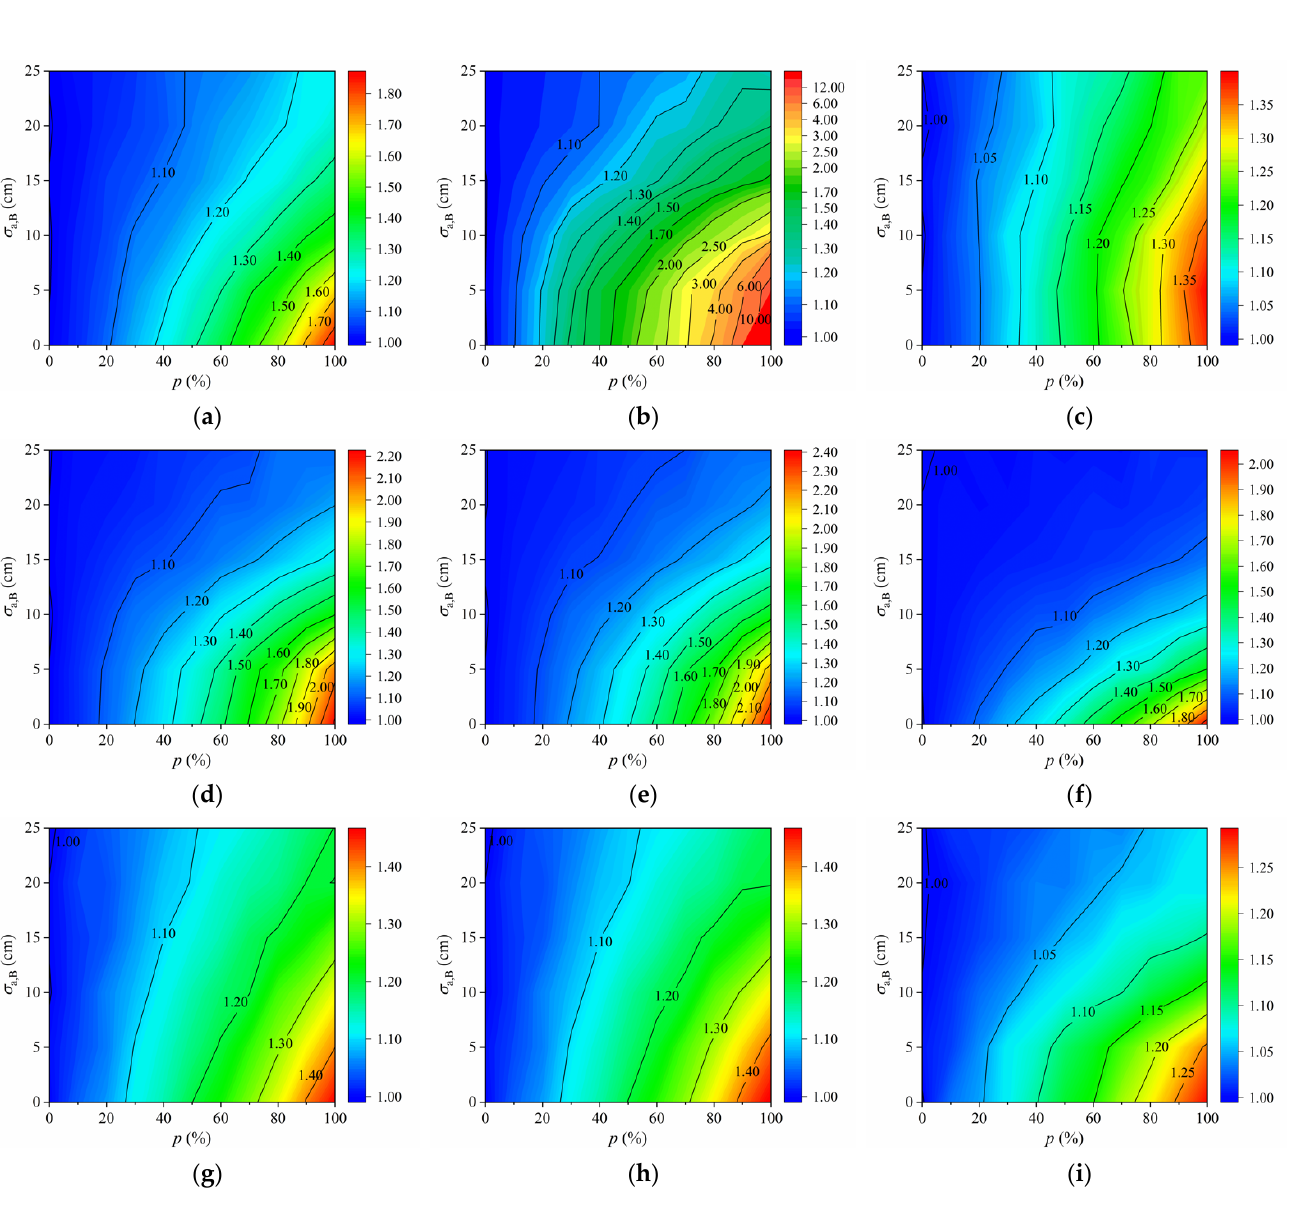
Figure 12. Y / Y of fatigue details under the scenario of Pattern 1: ( a ) D1 in COSD; ( b ) D2 in COSD; m h